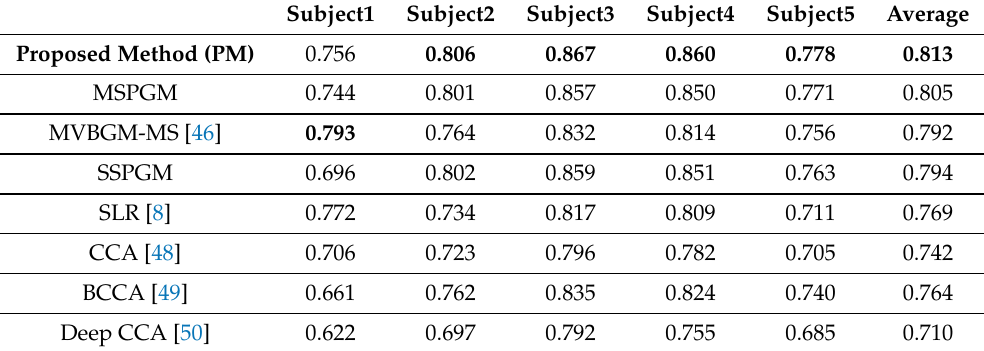
Table 1. Confidence category scores were averaged for 150 test images and five subjects in the PM and all CMs (The best scores for each subject, and the averages of all subjects are shown in